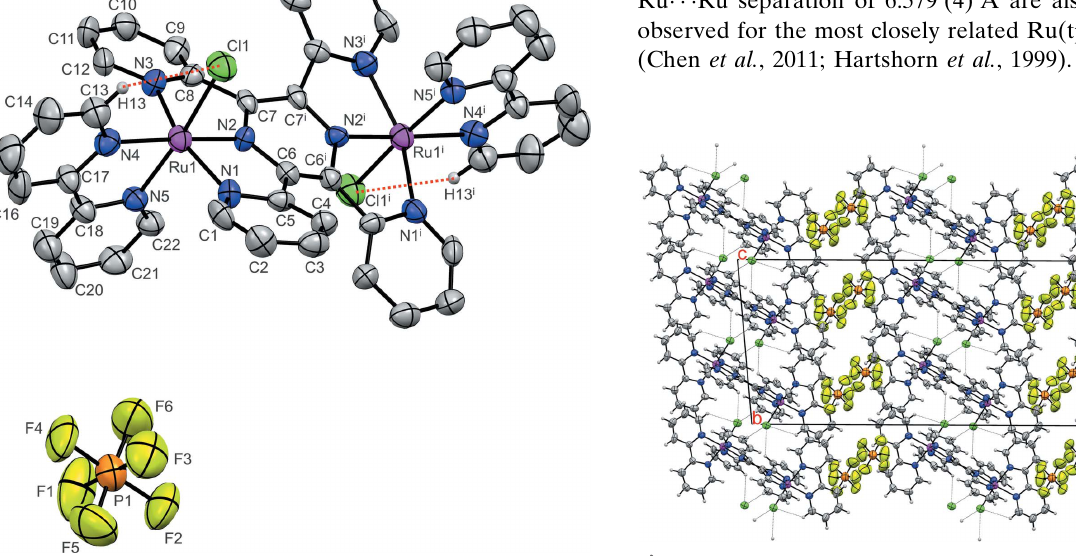
Figure 1 The molecular structure of the title compound, with displacement ellipsoids drawn at the 40% probability level. H atoms have been omitted for clarity, except for H13; its close contact with Cl1 is indicated by a red dotted line. [Symmetry code: (i) (cid:2) x + 1, y , (cid:2) z + 3